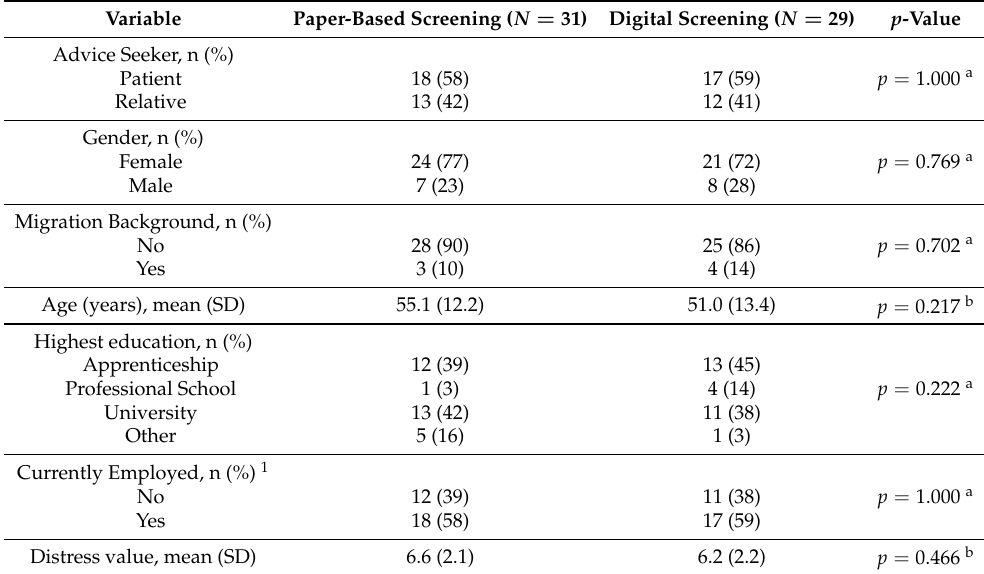
Table 1. Sample descriptions and comparisons between screening trials in baseline